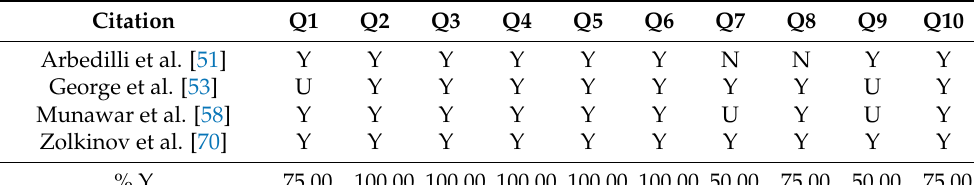
Table 4. Critical appraisal of qualitative